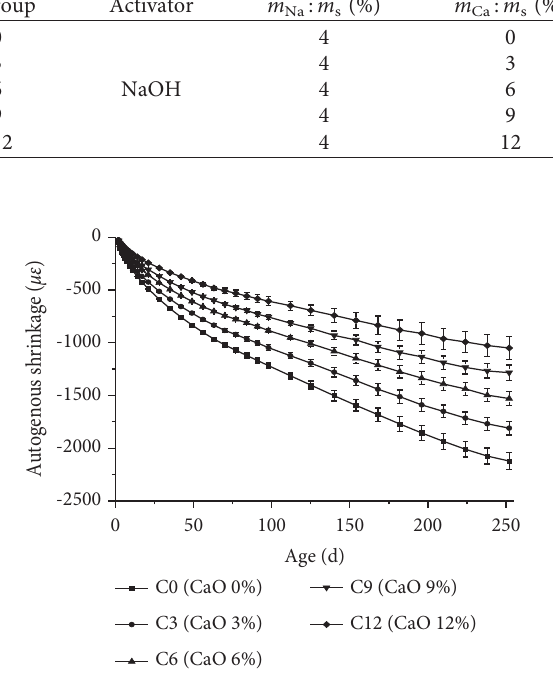
Figure 1: Autogenous shrinkage of AAS